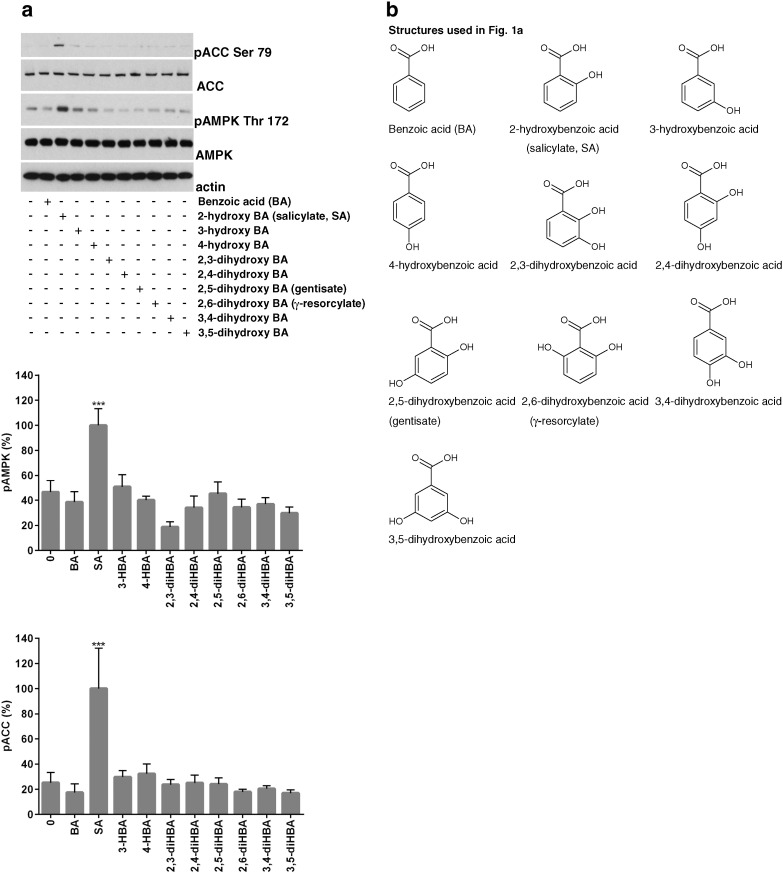
Comparison of effects of SA and analogues on AMPK signalling.(a,b) H4IIE cells were incubated in serum-free medium for 2 h, prior to stimulation for 3 h with or without the agents (10 mM) shown. Densitometry of blots from each experiment was carried out as described in the Materials and methods. Treatments significantly different from untreated cells are shown; ⁎⁎⁎p < .001, n = 5. Cells were then lysed and prepared for immunoblotting as described in the methods. Two acetyl-CoA carboxylase (ACC) antibodies were used, one which detects total ACC1/2 (ACC) and one which detects phosphorylated ACC1/2 (pACC Ser 79). A third and fourth antibody detects AMPK whether or not it is phosphorylated. A fifth antibody is to the housekeeping protein actin. (c) H4IIE cells were incubated in serum-free medium and then stimulated as in (a) but with a dose–response of SA as shown. Besides the antibodies used earlier, two S6 antibodies were used, one which detects total S6 protein (S6) and another one which detects phosphorylated S6 protein (pS6 Ser 240/244). Cells were then lysed and prepared for immunoblotting with antibodies as already described in the methods; ⁎p < .05, n = 3–4. (d) Lysates treated as in (a) were probed with the S6 antibodies just described. Two further antibodies, to detect p70S6K regardless of phosphorylation (p70S6K) or when phosphorylated on residue Thr389 (pp70S6K Thr389), were also used, n = 4.